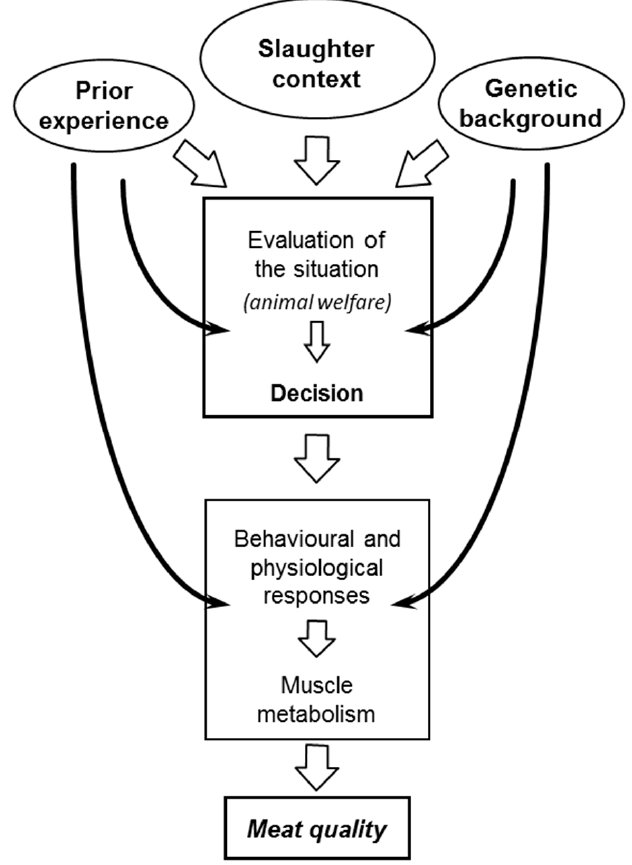
Figure 4. The way the animal evaluates its situation in slaughter (or other) contexts depends on the context itself and the genetic background (e.g., certain breeds or genetic types may be more reactive) and prior experiences of the animal (e.g., the experience an animal has with a certain situation influences the way it evaluates it). The context refers to the physiological state of the animal (e.g., fatigue, hunger, level of arousal, estrus) and its environment (e.g., presence of fear-inducing aspects). The way the animal evaluates its situation is related to its welfare state; the way it reacts to the preslaughter situation influences the qualities of its future meat. The effects of stress on meat quality also depend on the genetic and rearing background of the animal. Reproduced with permission from Elsevier, from [87] .